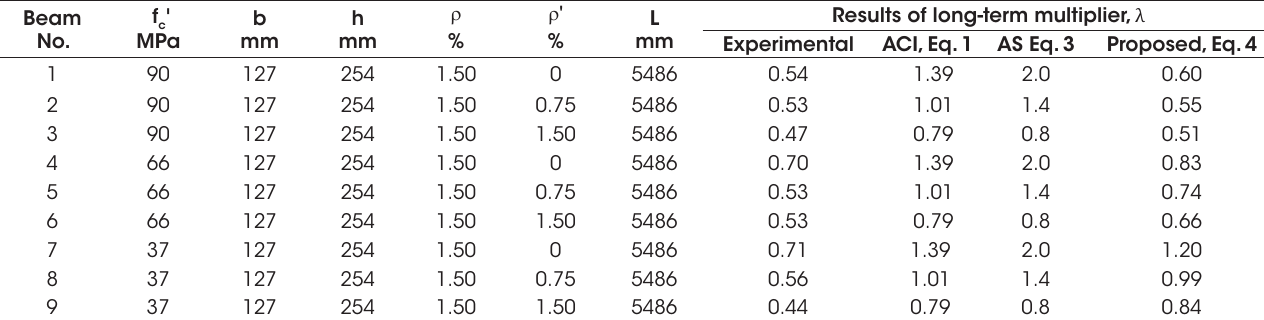
Validation of proposed long-term deflection multiplier ( λ ) with experimental results by [4], time of sustained loading = 1 years Beam